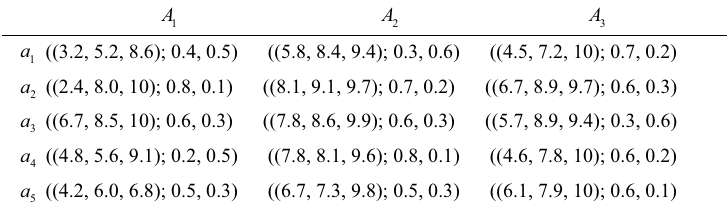
Table 2 The TIFN decision matrix given by